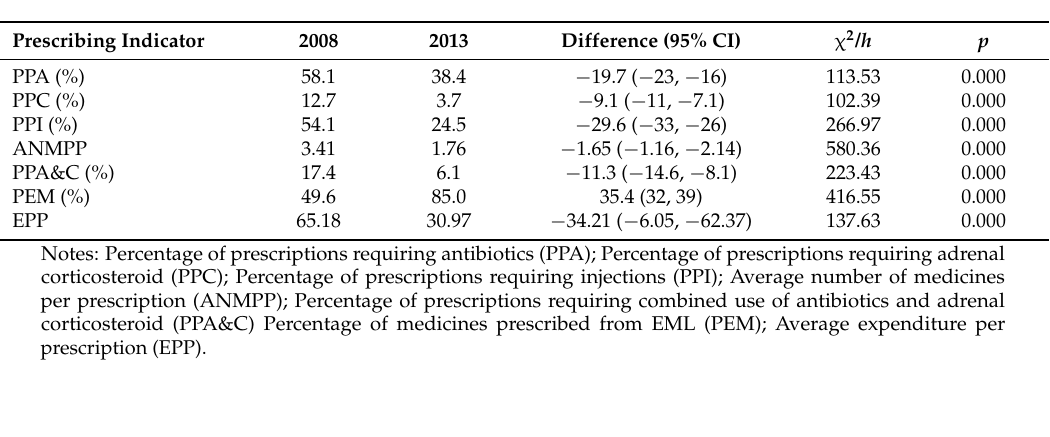
Table 3. Changing prescribing patterns in township hospitals from 2008 to